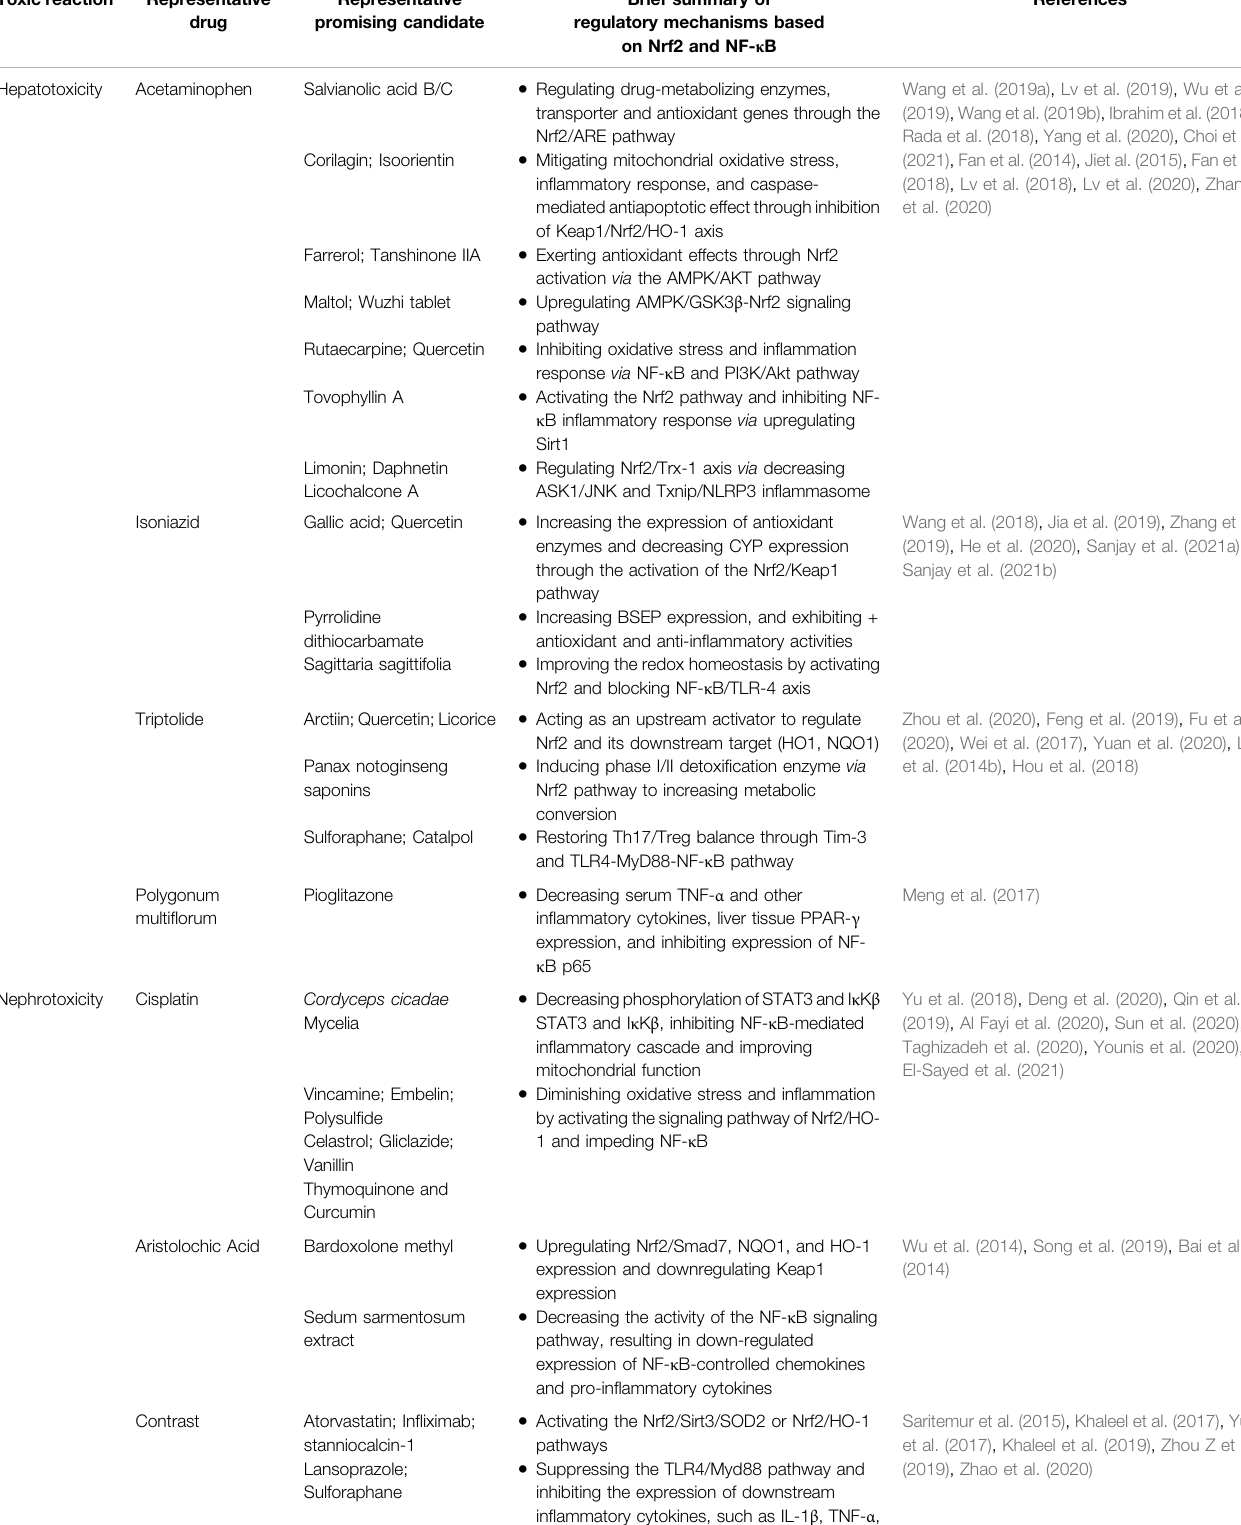
TABLE 1 | A summary of representative protective agents targeting the crosstalk between the Nrf2 and NF- κ B pathway in drug-induced toxicity. Toxic